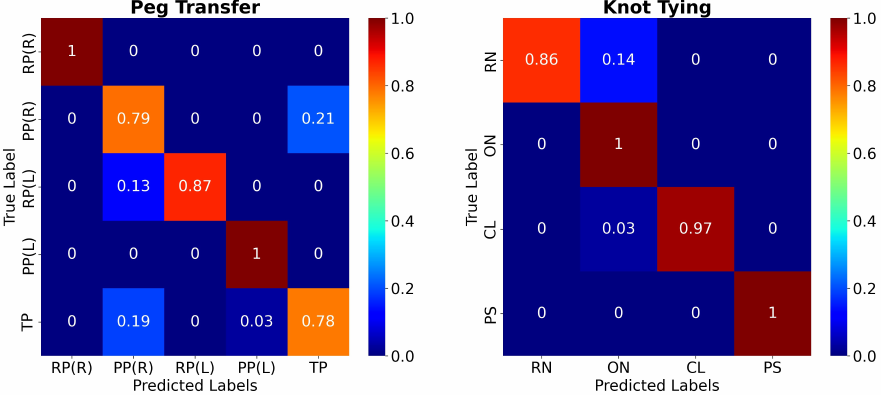
Figure 6. Color-coded confusion matrices of the proposed C3DTrans model for the PT (left) and KT (right) tasks. X- and Y-axes represent predicted and ground truth labels, respectively.